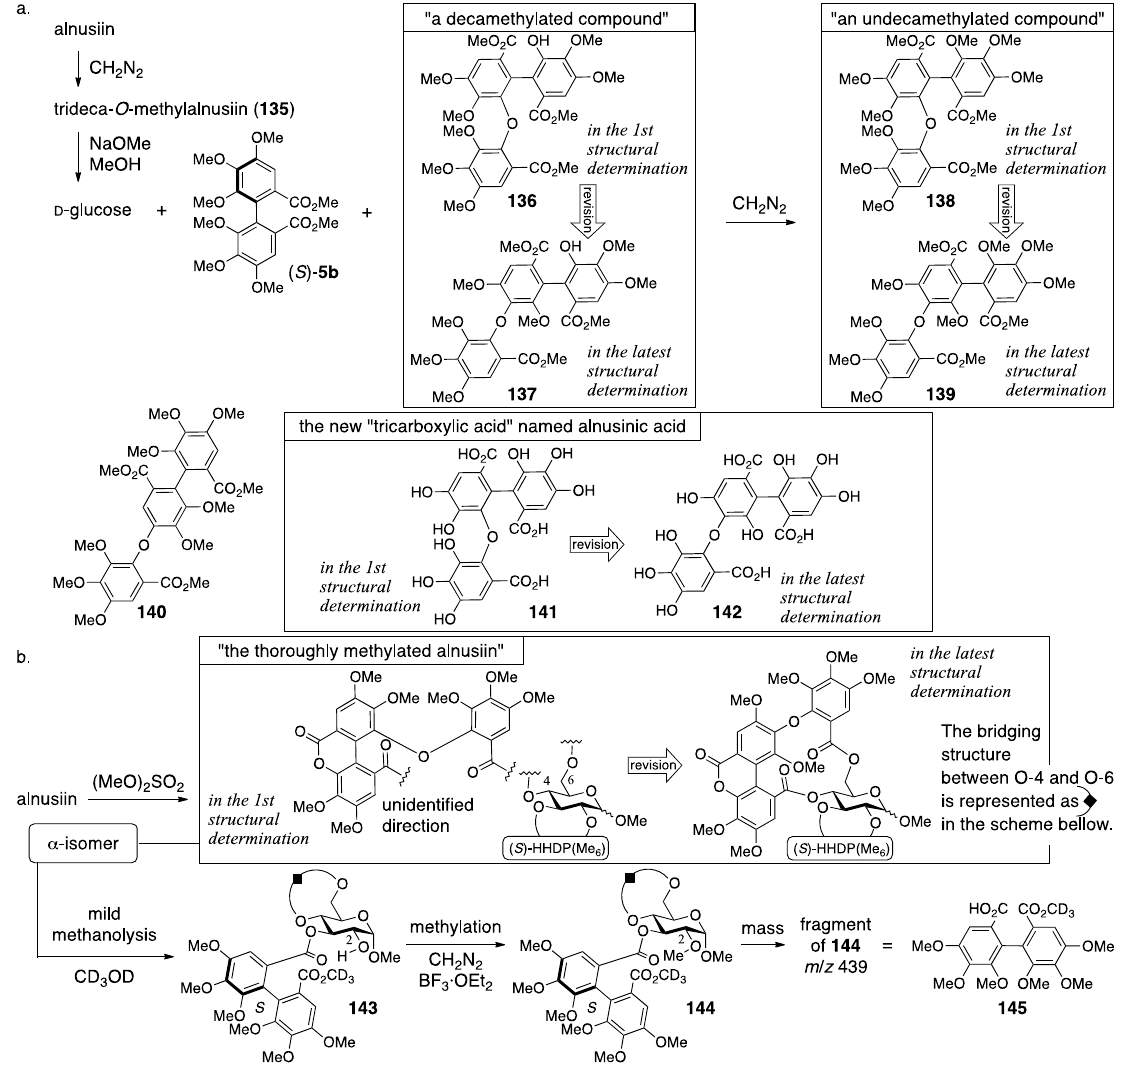
Figure 48. The information that led to 133 .